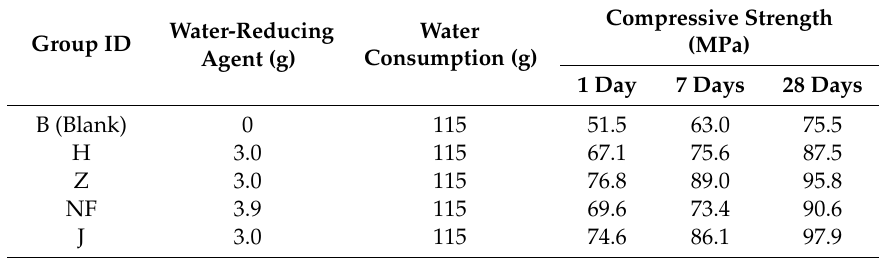
Table 5. E ff ects of functional polycarboxylic acid superplasticizers on the compressive strength of the cement